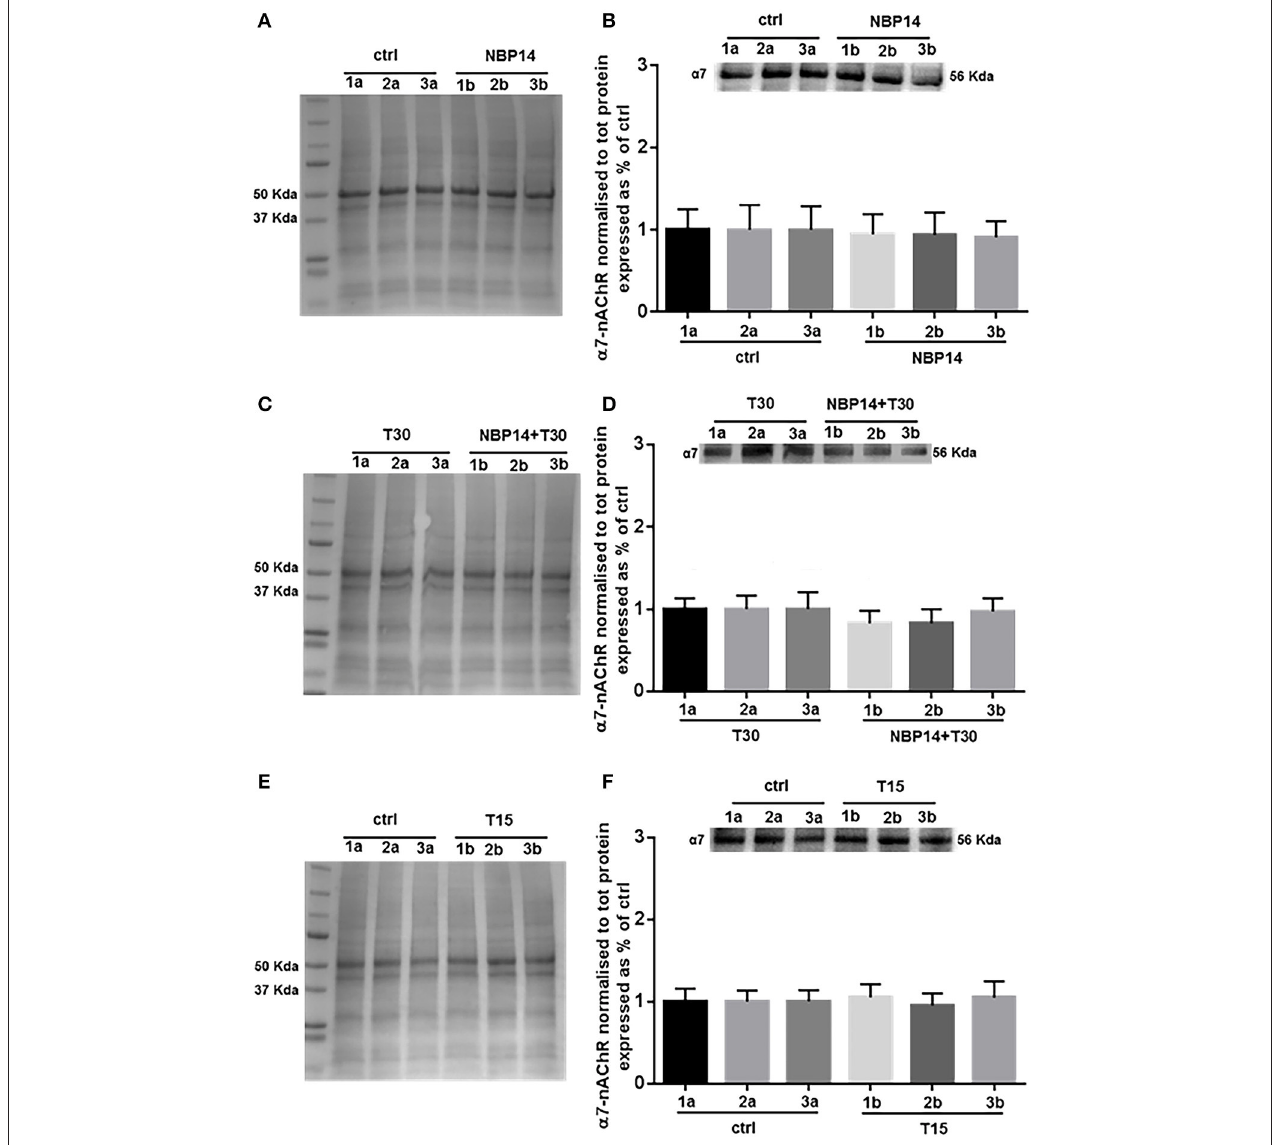
FIGURE 4 | α 7-nAChR levels show less variability along the basal forebrain axis following different treatments. (A,C,E) Representative total protein staining used as loading control. (B,D,F) Representative immunoblots and bar graphs indicating the α 7-nAChR levels along the three BF subdivisions. (A) Total protein membrane subsequently immunoblotted for α 7-nAChR. (B) The receptor did not show any rostro-caudal difference between the two conditions [ F (5, 55) = 0.3227, p = 0.8972, two-way ANOVA]. (C) Total protein membrane subsequently immunoblotted for α 7-nAChR. (D) No interaction was observed between conditions and anatomical subdivisions [ F (5, 35) = 1.503, p = 0.2139, two-way ANOVA]. (E) Total protein membrane subsequently immunoblotted for α 7-nAChR (F) No change was detected along the BF anatomical plane after T15 administration [ F (5, 35) = 0.2600, p = 0.9318, two-way ANOVA]. Protein changes were indicated as mean ± SEM. n = (hemisections per condition, rats) in (A,B) are (36, 12); in (C,D) (24, 8); in (E,F) (24,